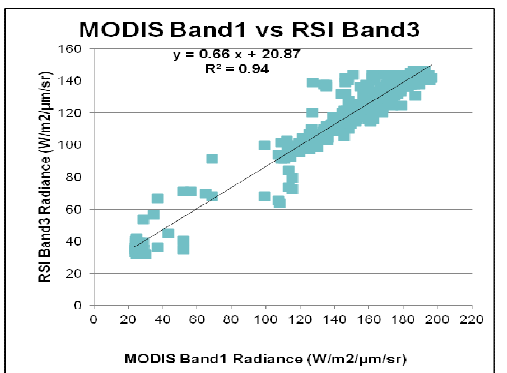
Figure 9. Sample area of different ice types extracted from MODIS image (Sea of Okhotsk, Feb. 7,